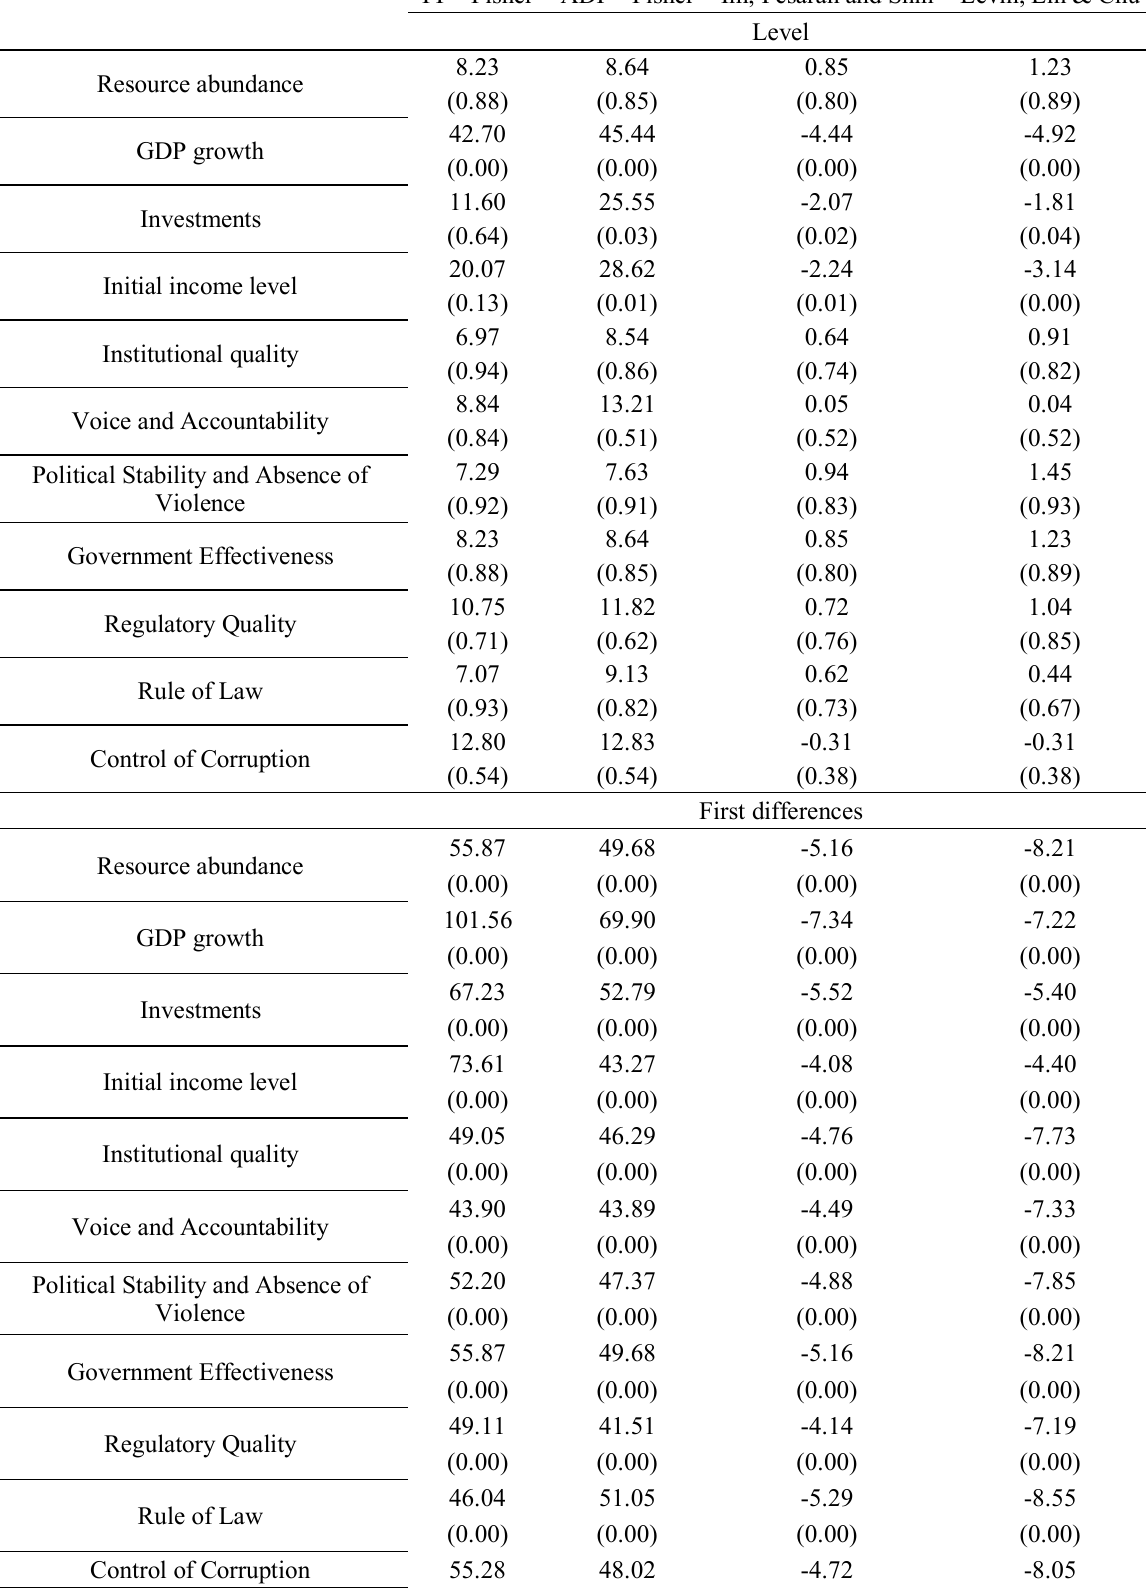
Table 1. Panel unit root tests